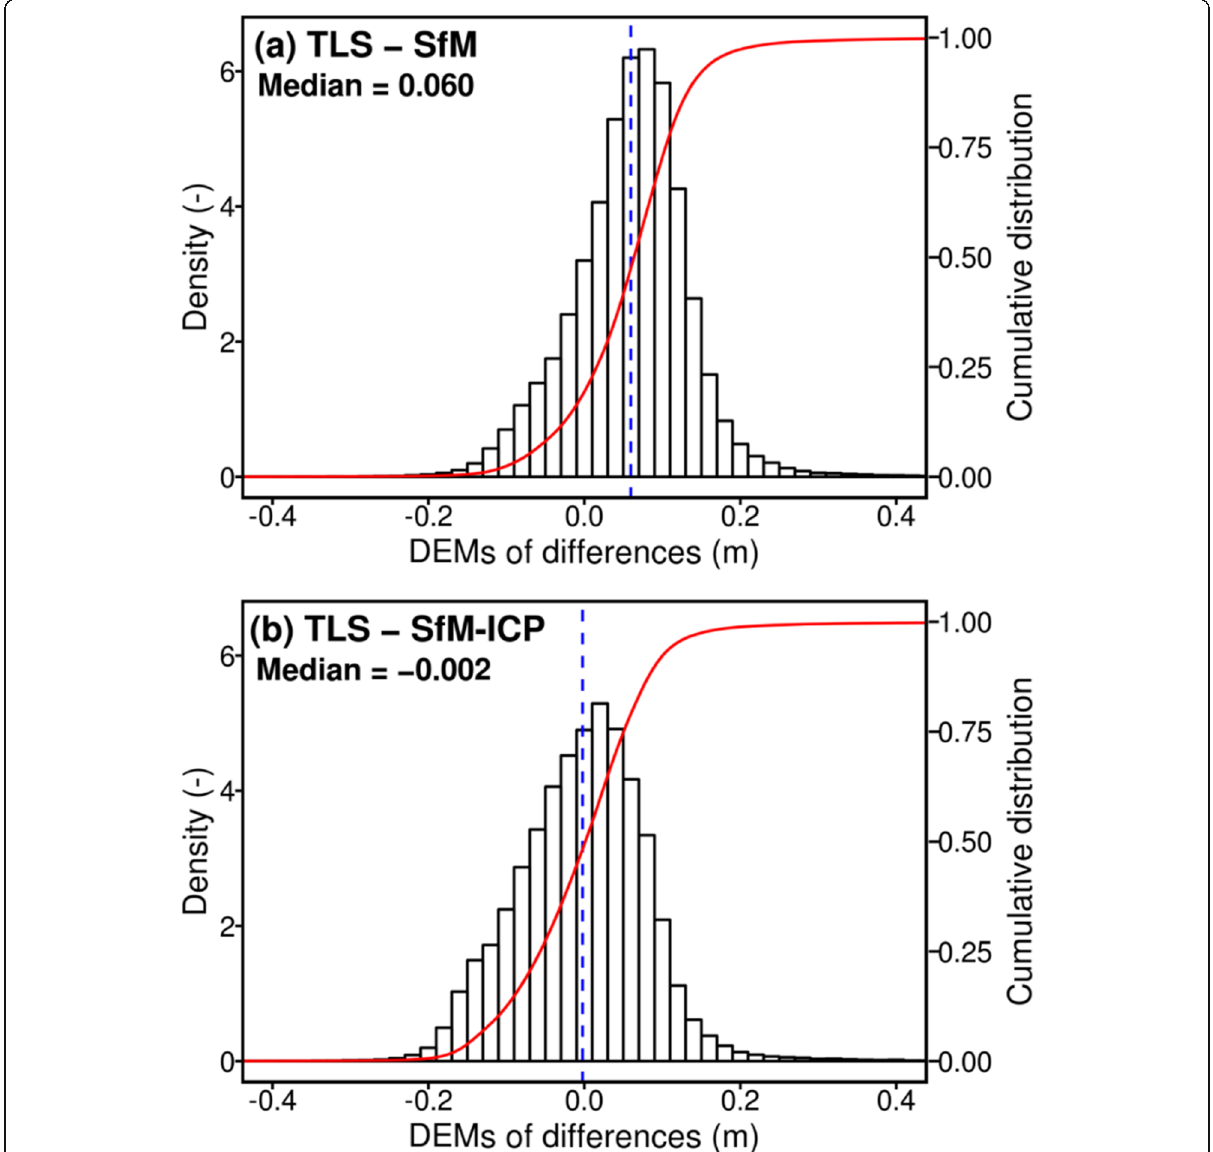
Fig. 4 Histograms of the DoDs in the vicinity of the channel deposits. a The DoD between DEM TLS and DEM SfM . b The DoD between DEM TLS and DEM SfM-ICP . The red line and dashed blue line indicate the cumulative distribution and the median value,